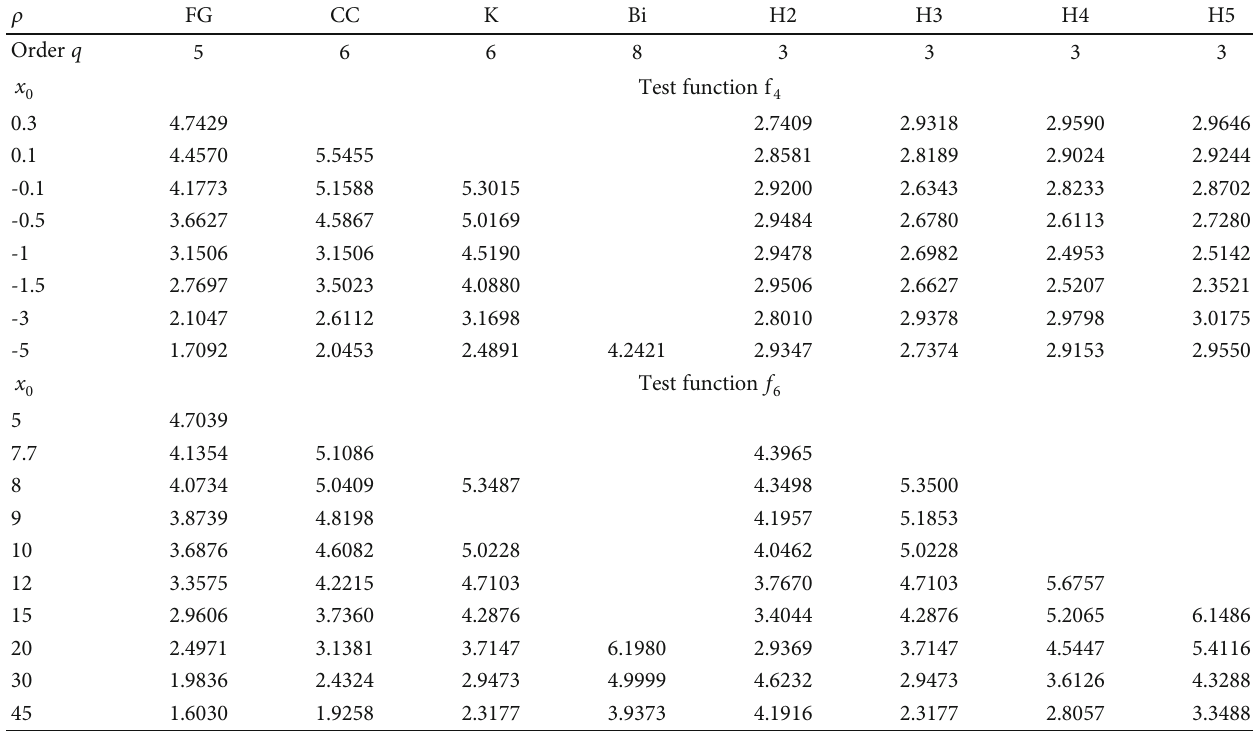
0 , for the test functions f 4 and f 6 :